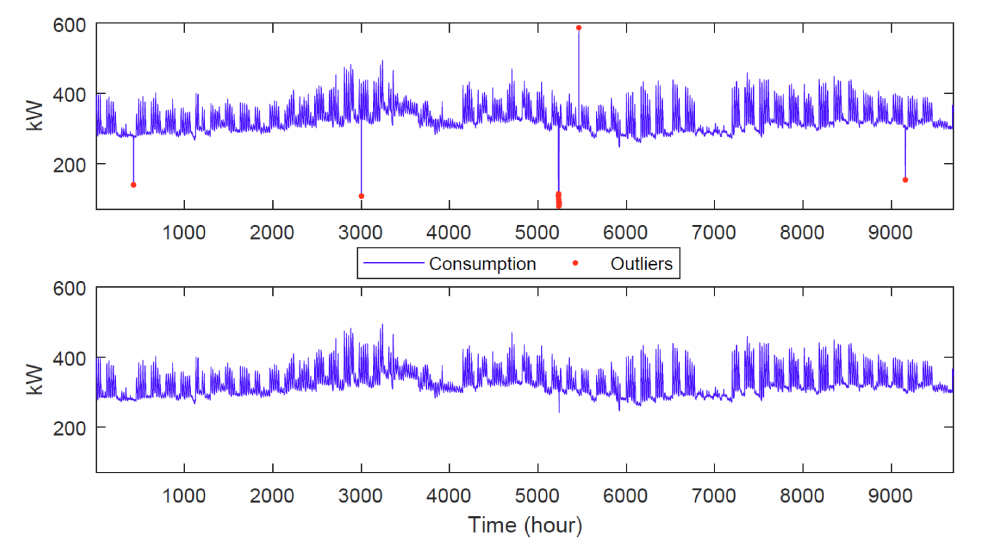
Figure 2. Example of the obtained result using the noise treatment on the time series. The first graph illustrates the time series with outliers detected. The second one shows the result after having removed these